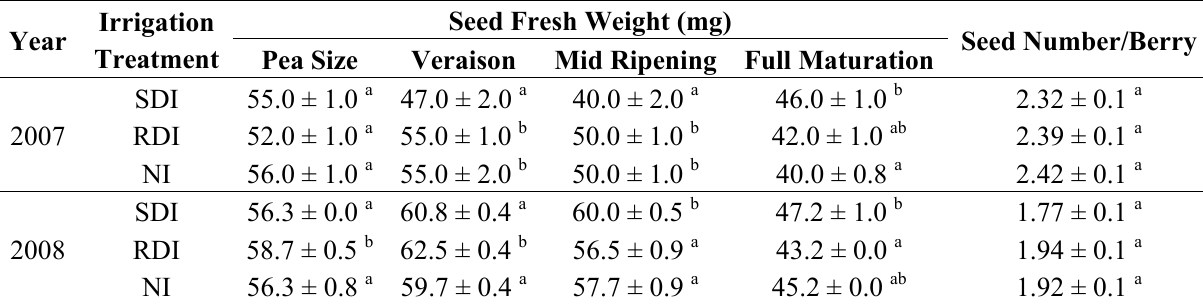
Table 1. Seed fresh weight (mg) and seed number in sustained deficit irrigation (SDI), regulated deficit irrigation (RDI) and non-irrigated (NI) berries during 2007 and 2008 seasons. Values are means ± SE ( n ≥ 4). Different letters (a, b, ab) indicate significant differences among treatments at the same date using Duncan’s test ( p ≤